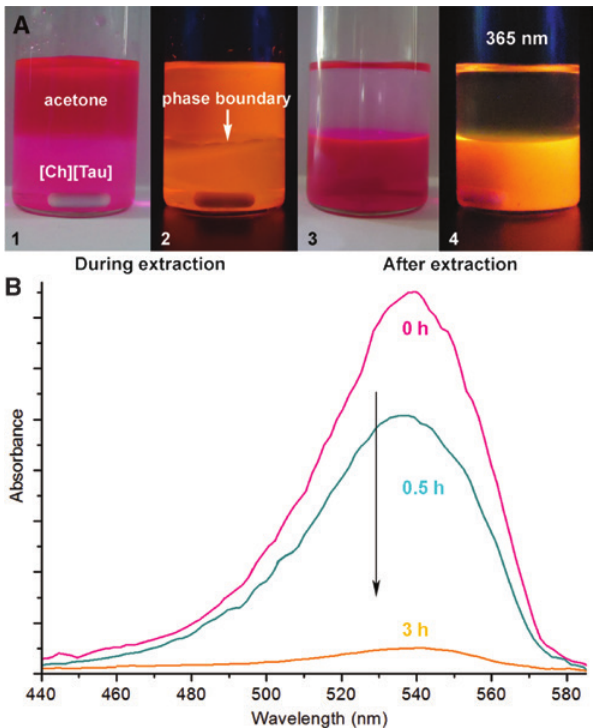
Figure 2: Photographs of the vessel during and after extraction under visible light and UV (A); UV-Vis spectroscopic tracing of the extraction of Rhodamine B (5 mm) with [Ch][Tau] (B). (A) Digital photographs of dye solutions during (left) and after (right) extrac- tion. A significant color change in organic layer from bright rose red to nearly colorless could be observed by the naked eye. Under UV light the initial RB solution showed a brilliant yellow fluorescence, which changed to very weak fluorescence emission after extraction. (B) Absorption curves, respectively correspond to the UV absorption spectra after 0 h (pink), 0.5 h (green), and 3 h (orange). The direc- tion of arrow indicates the downward trend of UV